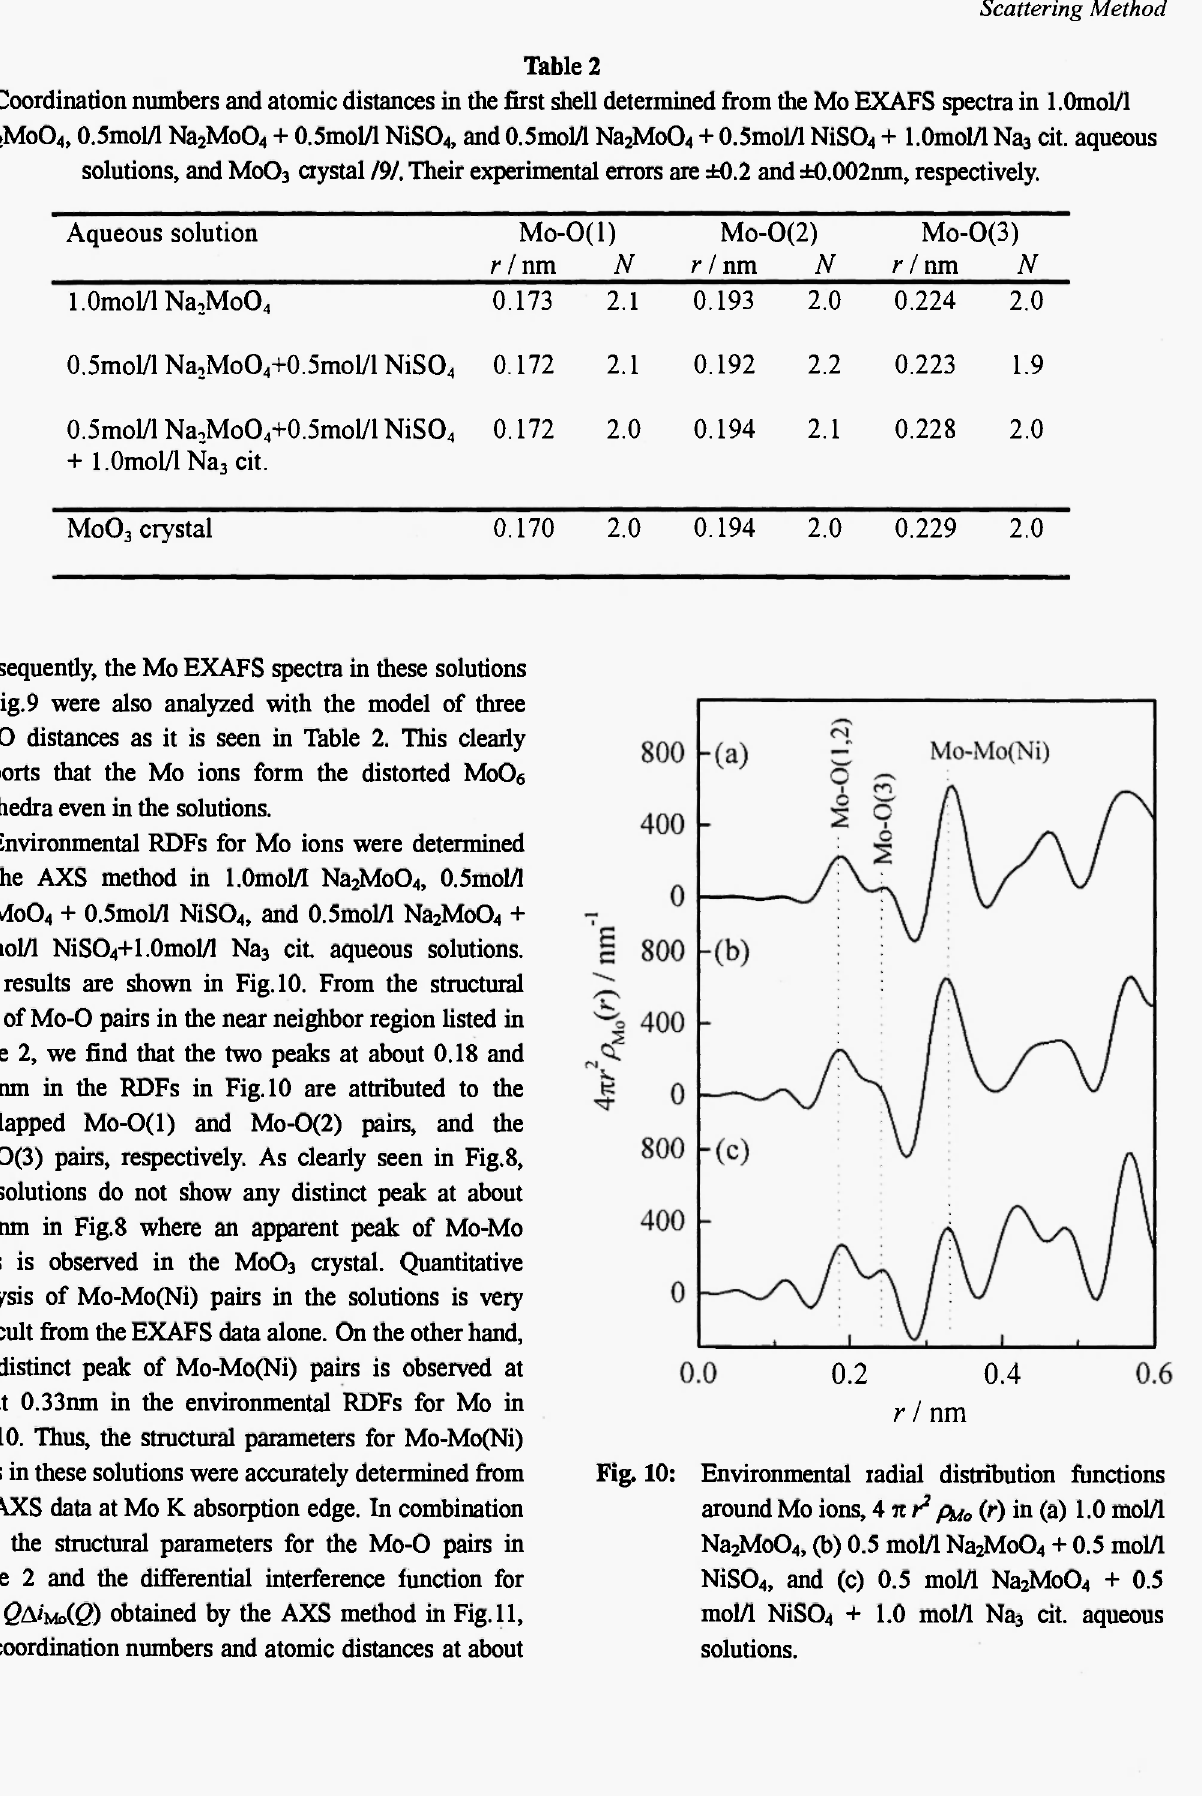
+ 1.0mol/l Na cit. aqueous 4 3